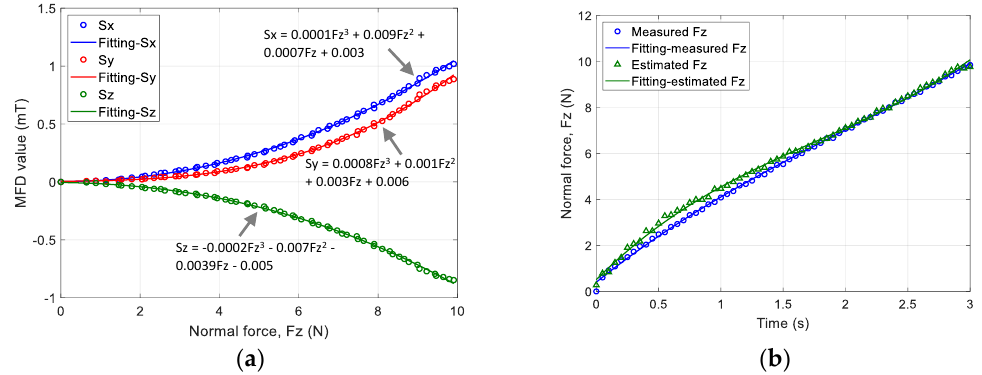
Figure 13. ( a ) MFD value of 3-axis sensor output vs. normal force Fz. ( b ) Measured normal force and normal force estimated using FNN with one hidden layer.